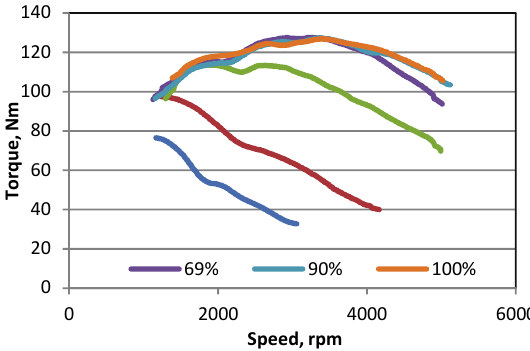
Fig. 7. Engine torque for different WOT. Fuel LPG/DME: 91/9%